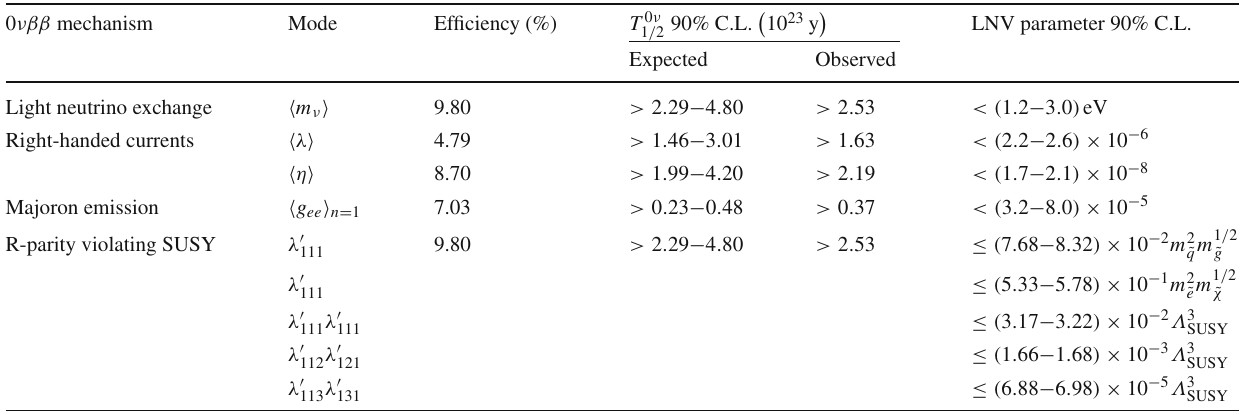
on the background model and signal efficiency. The ranges in the LNV parameter are due to the spread in NME calculations. The R-parity violating SUSY LNV parameters correspond to sparticle masses and energy scale Λ SUSY in TeV